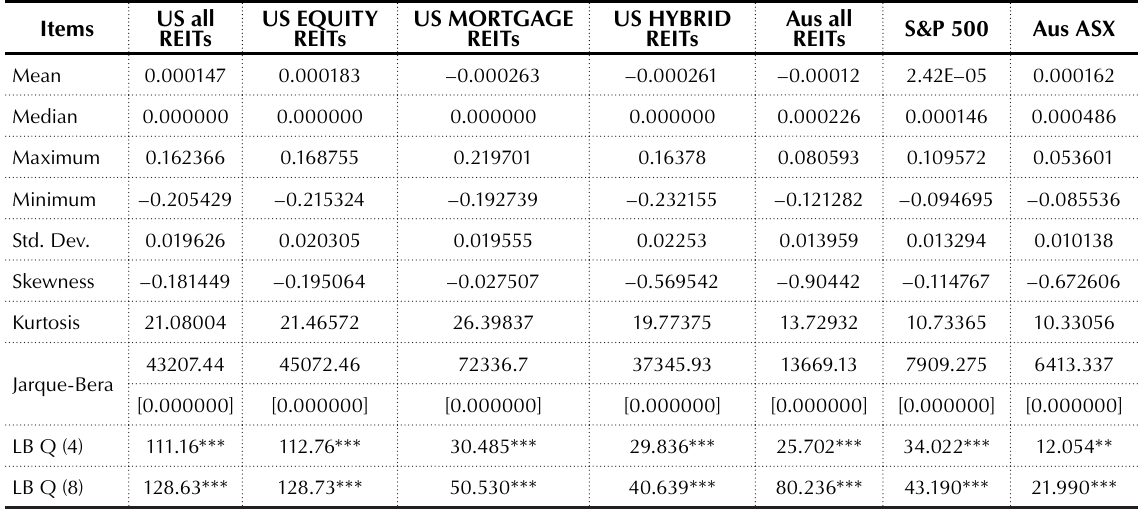
Table 1. Descriptive statistics of REIT index returns in the US and Australia